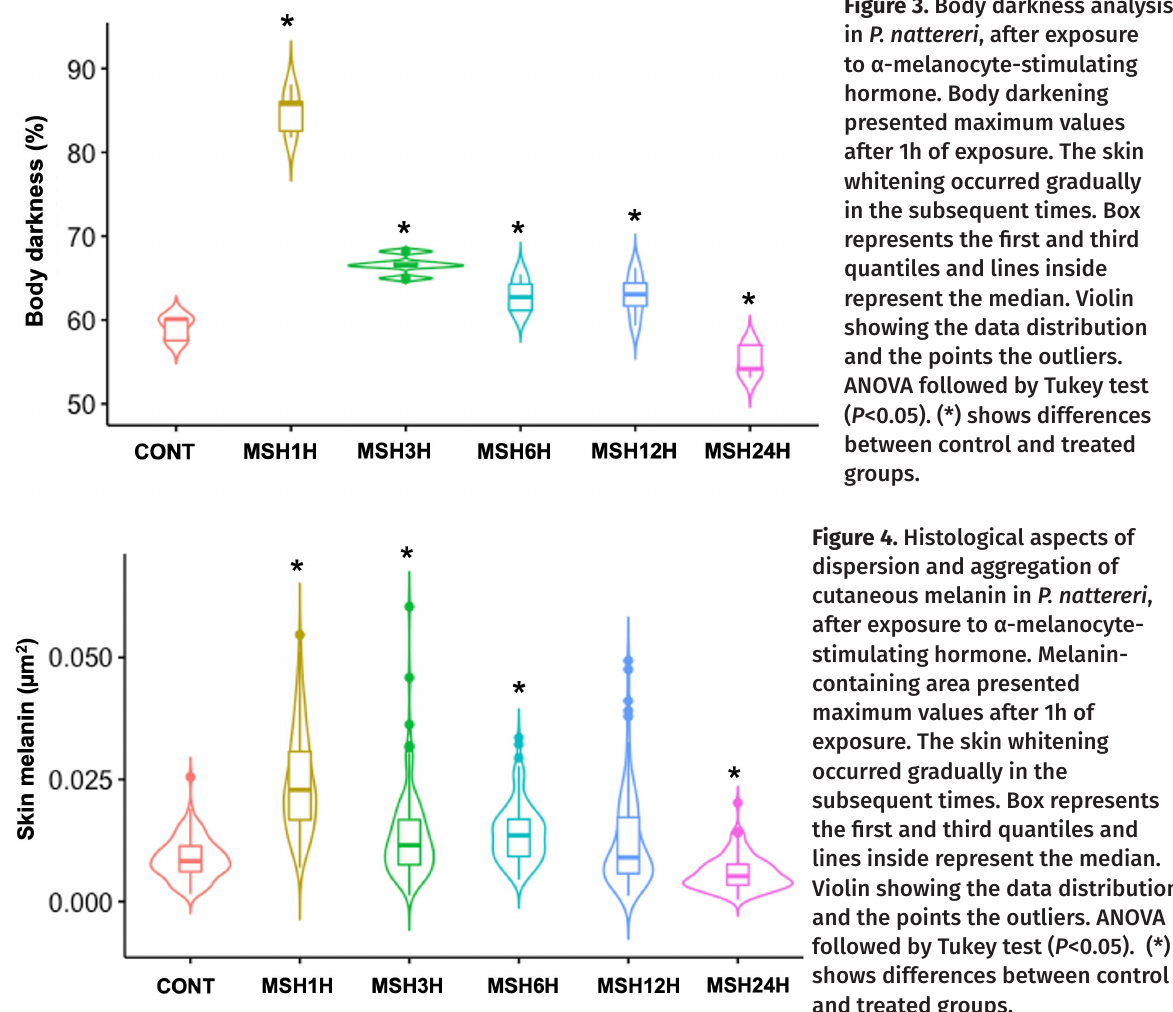
Figure 3. Body darkness analysis in P. nattereri , after exposure to α-melanocyte-stimulating hormone. Body darkening presented maximum values after 1h of exposure. The skin whitening occurred gradually in the subsequent times. Box represents the first and third quantiles and lines inside represent the median. Violin showing the data distribution and the points the outliers. ANOVA followed by Tukey test ( P <0.05). (*) shows differences between control and treated groups. Figure 4. Histological aspects of dispersion and aggregation of cutaneous melanin in P. nattereri , after exposure to α-melanocyte- stimulating hormone. Melanin- containing area presented maximum values after 1h of exposure. The skin whitening occurred gradually in the subsequent times. Box represents the first and third quantiles and lines inside represent the median. Violin showing the data distribution and the points the outliers. ANOVA followed by Tukey test ( P <0.05). (*) shows differences between control and treated